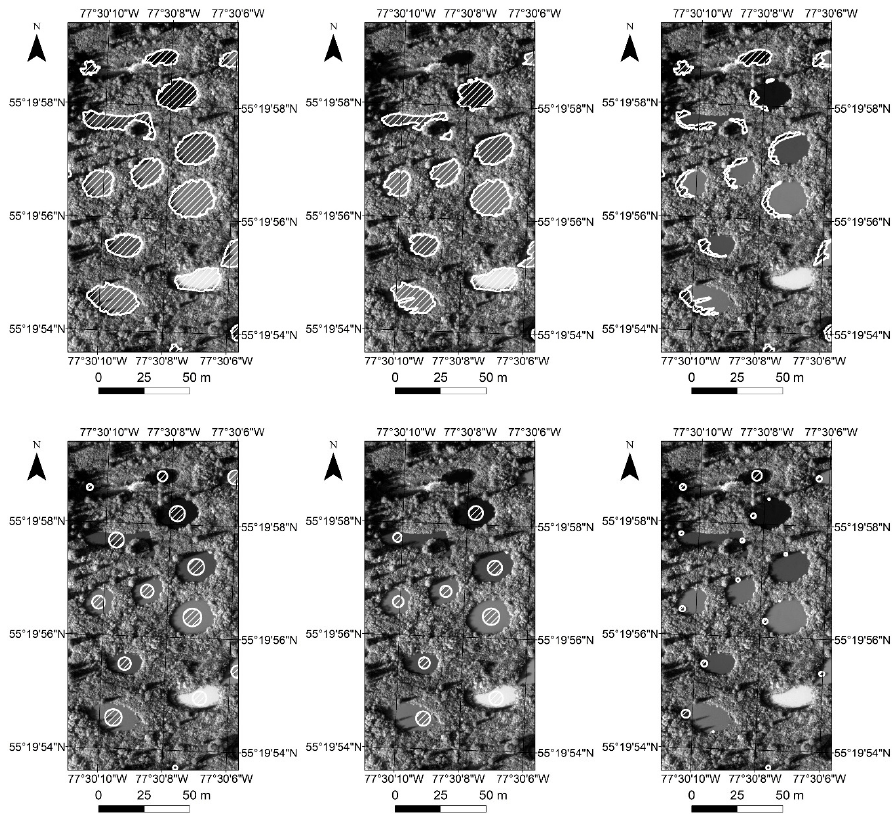
Figure 7. Methods used for the extraction of surface reflectance from the lake and pond surfaces from the Parrot Sequoia imagery. Upper row: average of the whole area of the marked polygons (M1 S), lower row: average of 20% area at the center of the target (M2 S). Left column: full-water body (FWB), Center column: sunlit water body (SLW), right column: shaded water body (SHD).